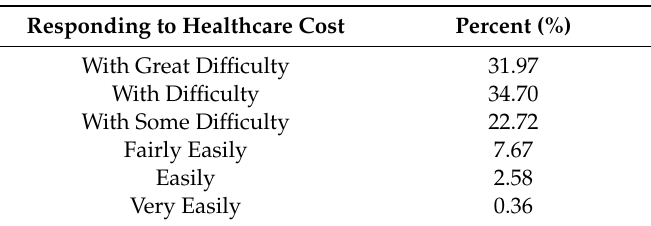
Table 4. Healthcare a ff ordability.